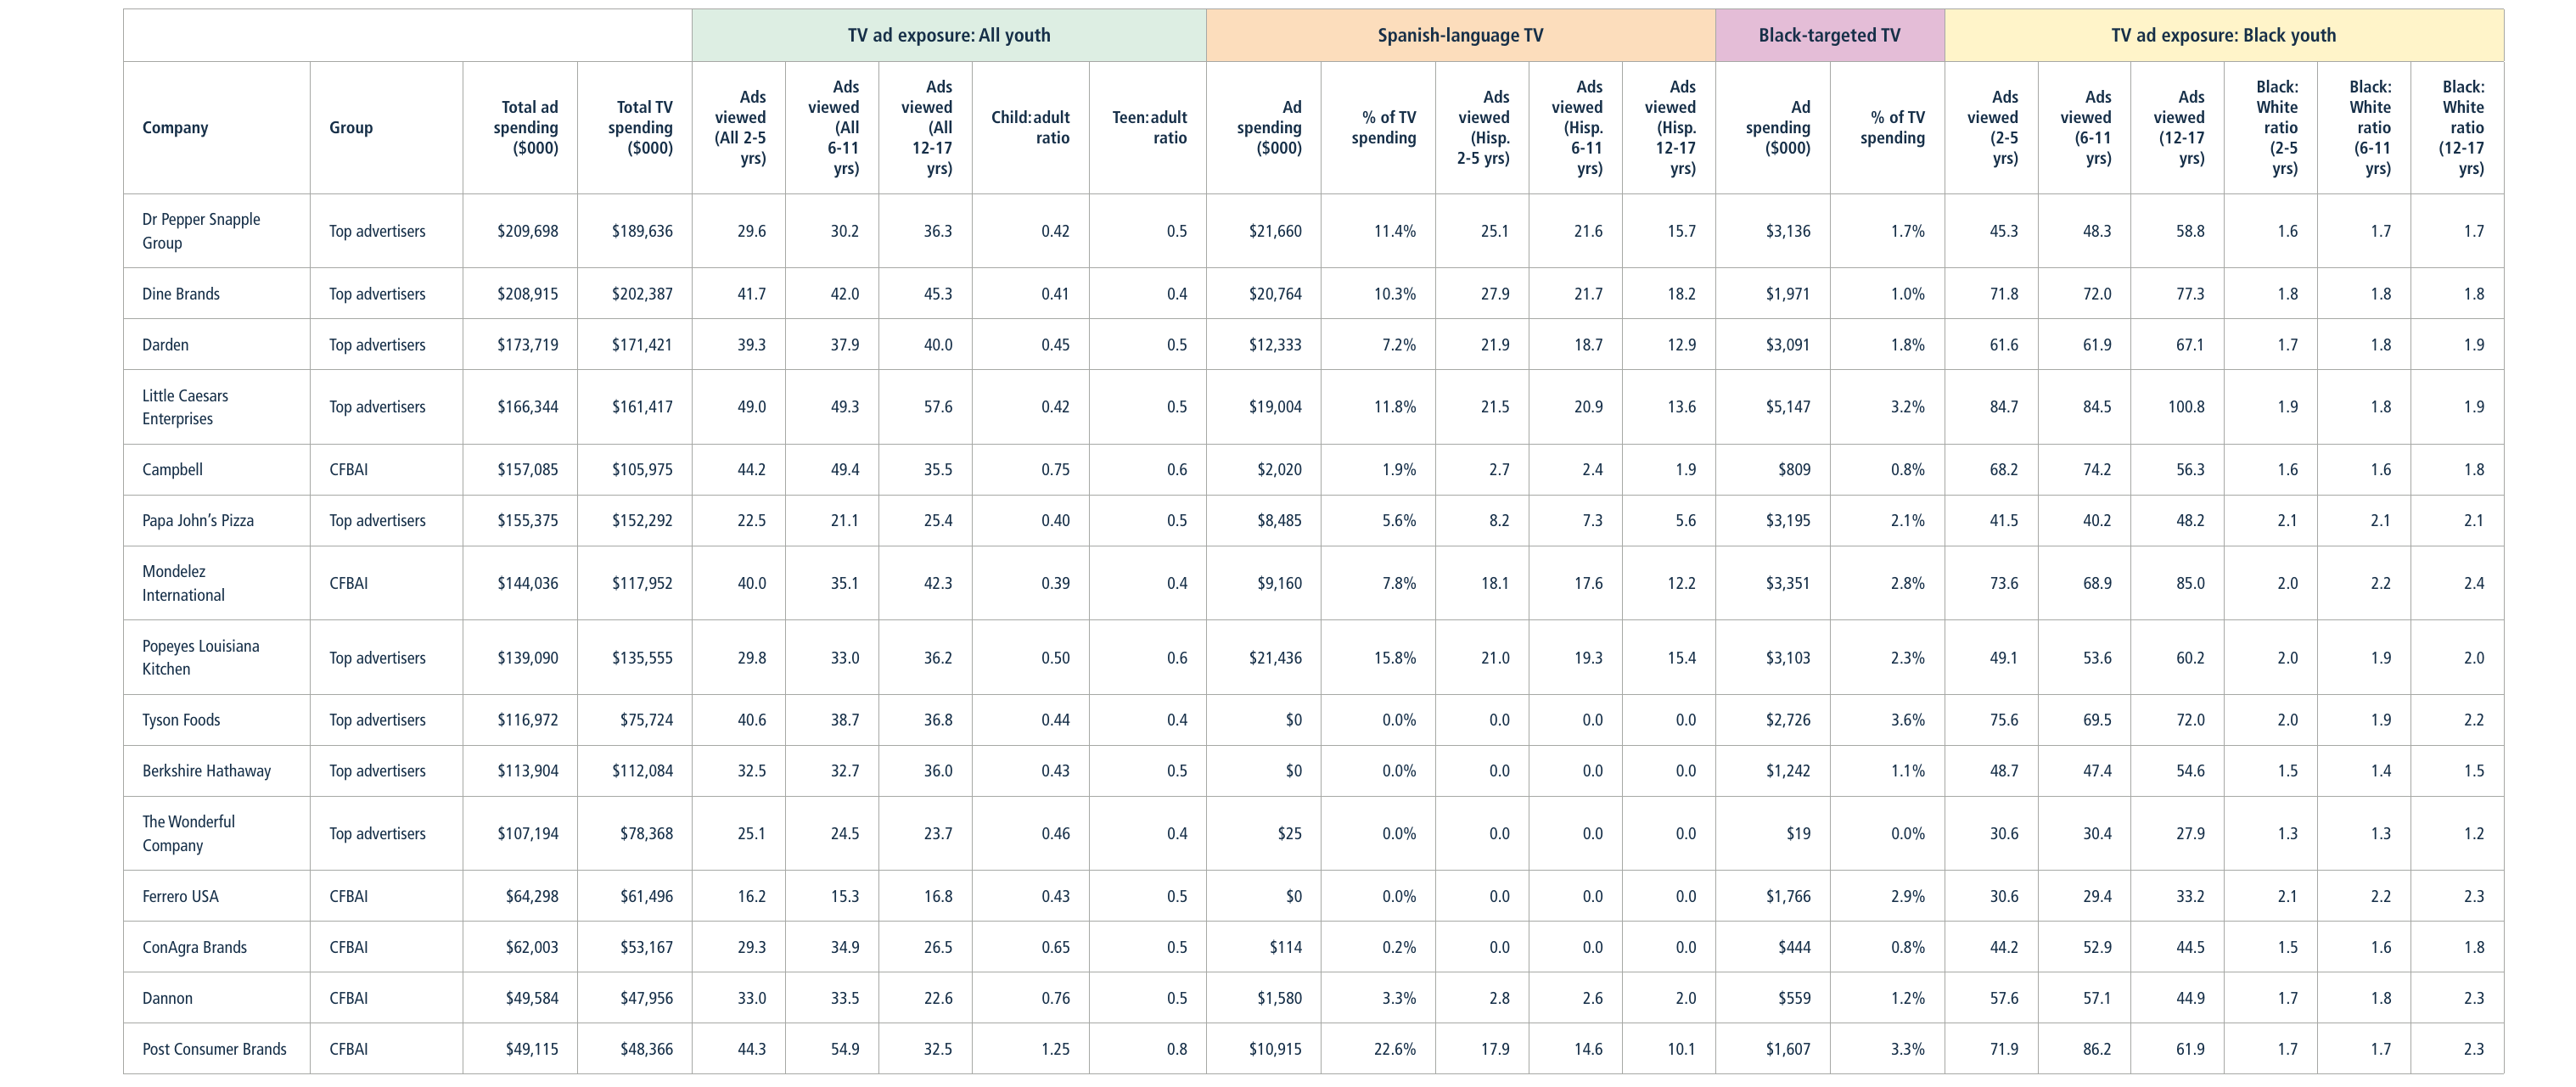
TABLE 1. TARGETED ADVERTISING BY COMPANY